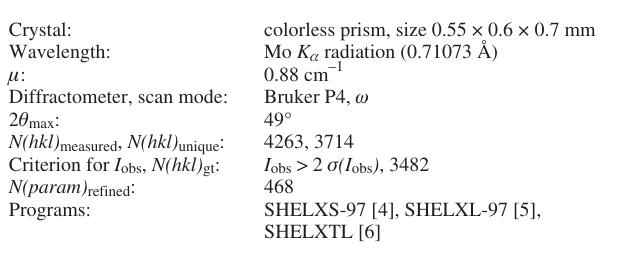
Table 1. Data collection and handling.